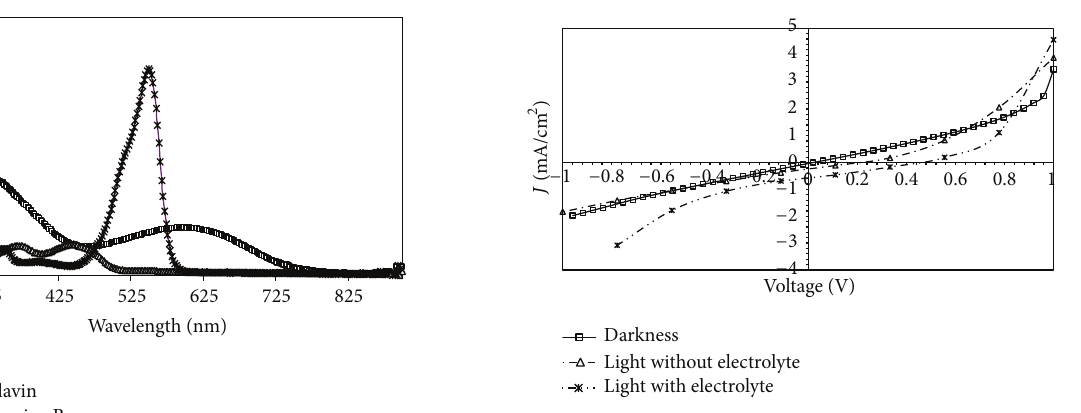
Figure 3: 𝐽 - 𝑉 characteristics curves of ITO/EB-MWCNT/ZnO- rhodamine B/ITO structure in darkness and illumination and with and without